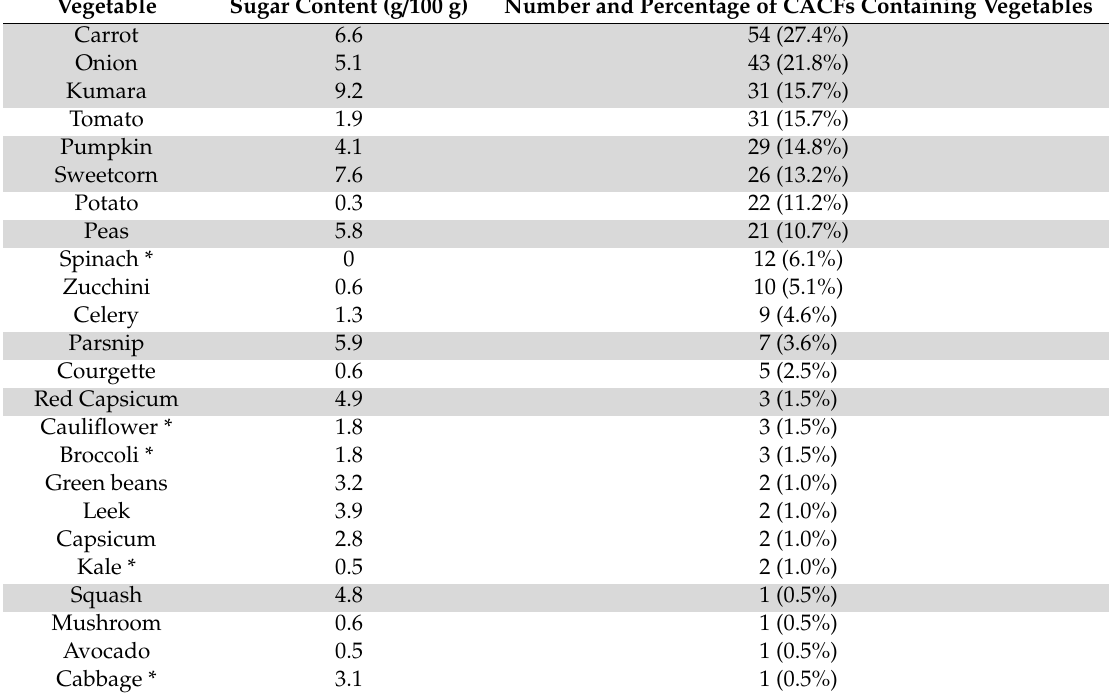
Table 4. Types of vegetables used in commercially available complementary foods (CACFs) in New Zealand supermarkets in 2019 along with their total sugar content (g / 100 g) and frequency of use (number and